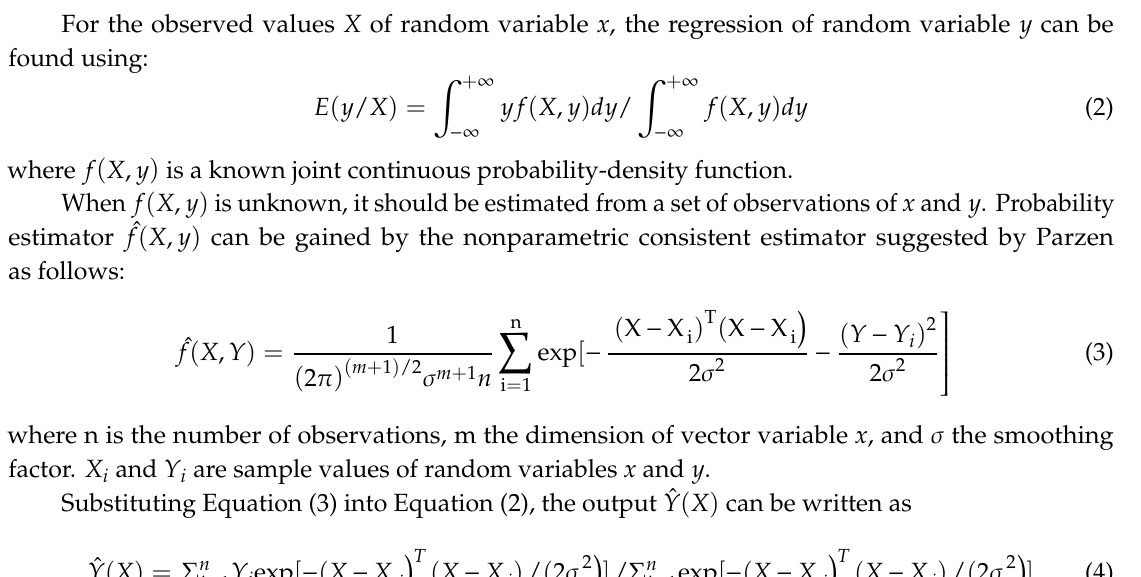
Figure 5. Selected experiment targets: ( a ) first target, pontoon; ( b ) second target, cube; ( c ) third target, triangular prism; ( d ) fourth target, reflector; and ( e ) fifth target, sphere.